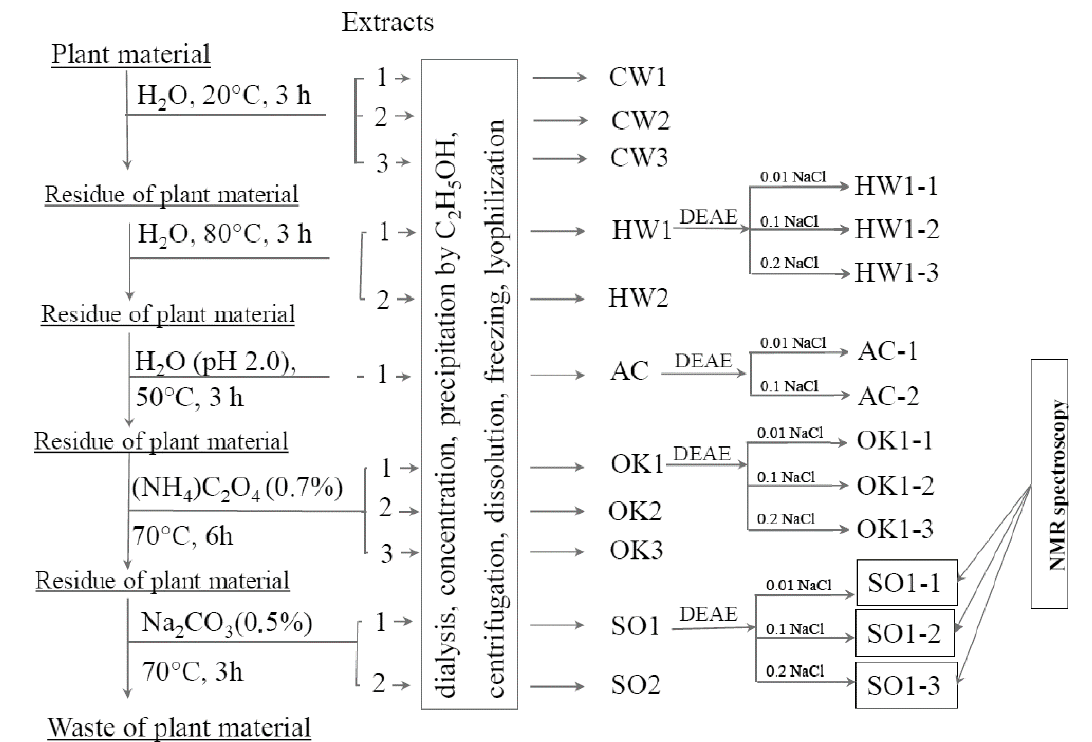
Figure 1. Scheme of isolation of polysaccharides from the S. passerine . Table 1. Chemical characteristics of pectic polysaccharides from the S. passerine .